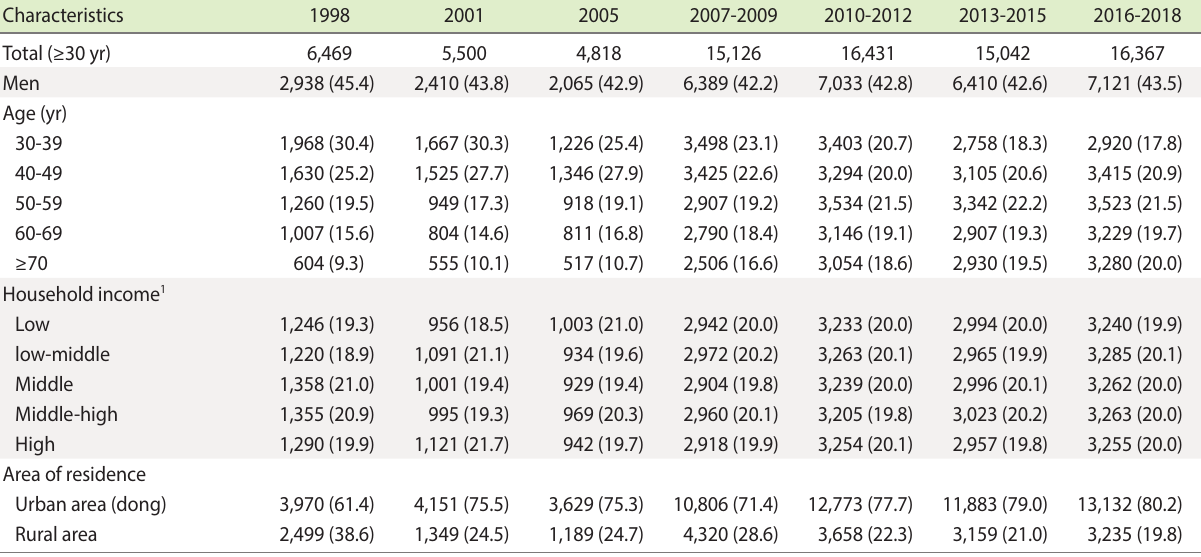
Table 1. Characteristics of health examination participants of Korea National Health and Nutrition Exami nation Survey